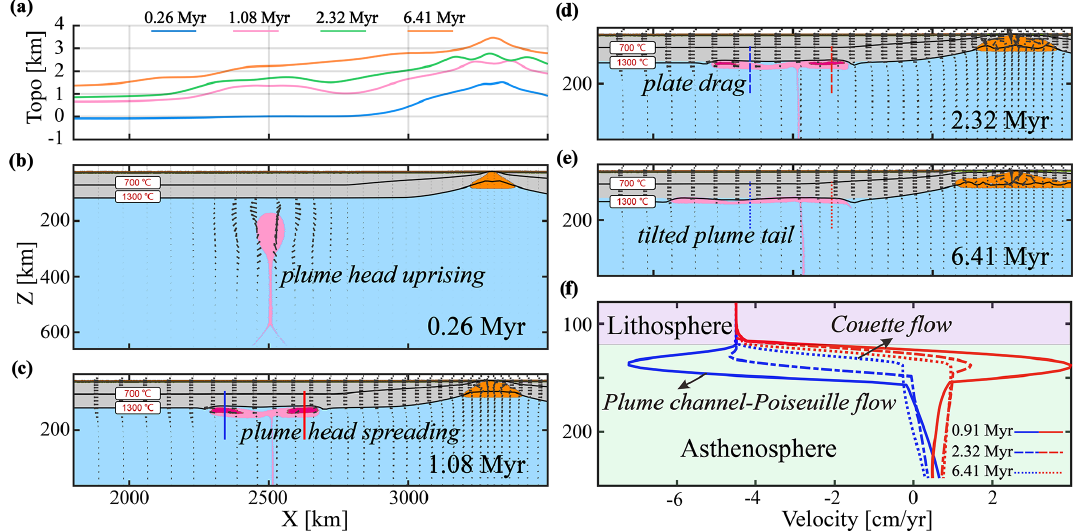
Figure 4. Same as Fig. 3 for case M77 (i.e., the reference model for the plate-drag plume flow regime). The main model parameters employed in this case are as follows: half-spreading rate of 45mmyr − 1 , an initial plume head radius of 100km and an off-axis distance of 800km.